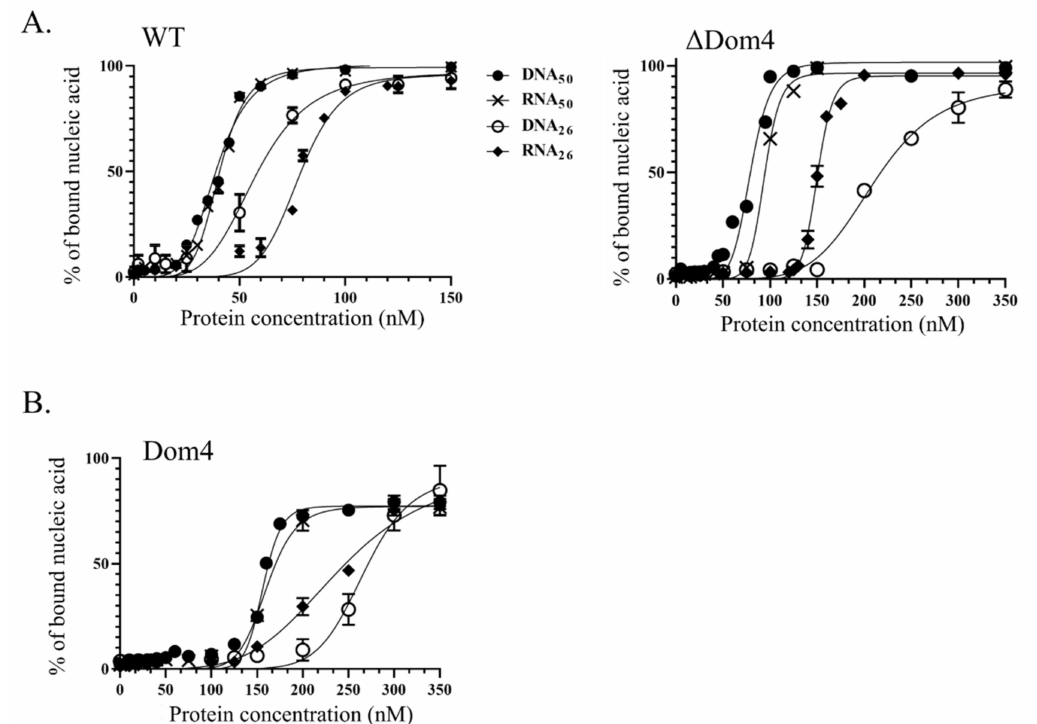
Figure 6. Binding affinities of wild type (WT) Tbar -aLhr2 and derivatives for single-stranded nucleic acids. ( A ) Using WT and ∆ Dom4 Tbar -aLhr2, the percentage of nucleoprotein complex formed after 15 min of incubation was plotted against the protein concentrations. The experiments were carried with RNA 50 , RNA 26 , DNA 50 and DNA 26 substrates (Supplementary Table S4). Three independent experiments were performed in each condition. ( B ) Identical assays were performed with a recombinant protein corresponding to Domain 4 alone.